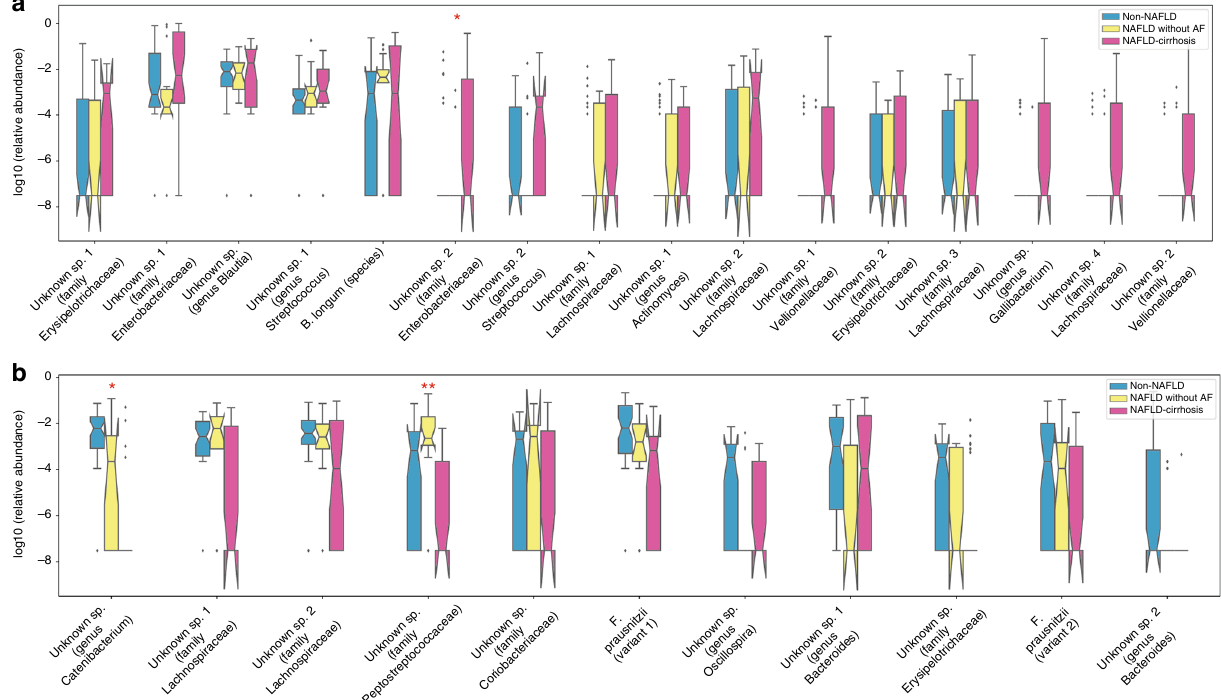
Fig. 3 Relative abundance of predictive microbial features for the prediction of NAFLD-cirrhosis. The bacterial features most predictive of NAFLD-cirrhosis ( n = 25) versus non-NAFLD controls ( n = 51) sorted by decreasing importance score in Random Forest classi fi cation model. Features increased ( a ) and decreased ( b ) in NAFLD-cirrhosis probands are shown. Relative abundance is plotted for each subject group in the cohort (NAFLD-cirrhosis in pink ( n = 25), NAFLD without advanced fi brosis in yellow ( n = 17) and non-NAFLD controls in blue ( n = 51)). The feature table is normalized to a total abundance of 1 per sample and relative abundances are plotted on a log10 scale. Each bacterial feature is a unique 16S tag sequence labeled to the highest possible taxonomic rank assigned using QIIME. The box plots show the quartiles and whiskers show the rest of the distribution (1.5 inter-quartile range). The notches show 95% con fi dence interval. Features that are differentially abundant in addition to being important predictors are marked by asterisk. Single asterisk (*) represents signi fi cant difference between non-NAFLD controls and NAFLD-cirrhosis probands p value < 0.05; Double asterisk (**) represents the same between NAFLD without advanced fi brosis and NAFLD cirrhosis probands p value < 0.05. Differential abundance was tested using permutation-based, ranked mean test, comparing mean difference between the two groups 63 . FDR (<0.1) was controlled using DS-FDR method 64 . Source data are provided as a Source Data fi le